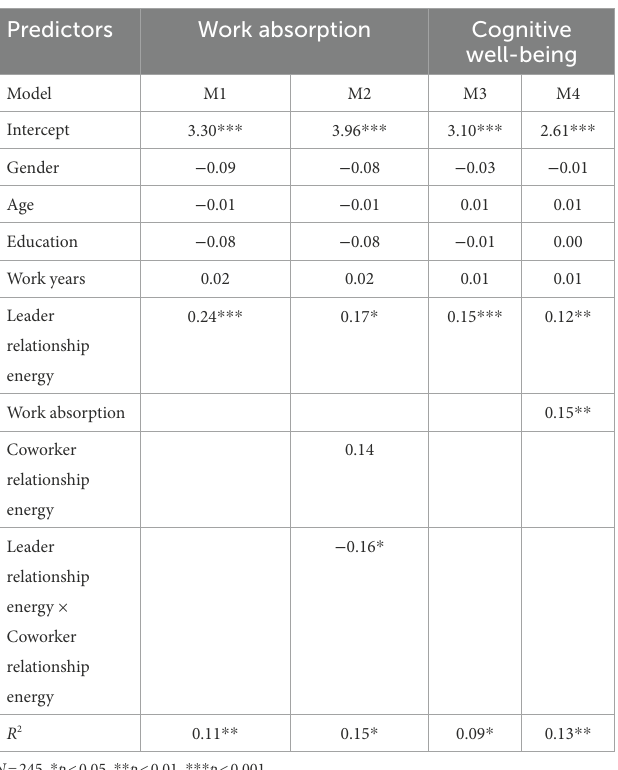
TABLE 4 Results of regression